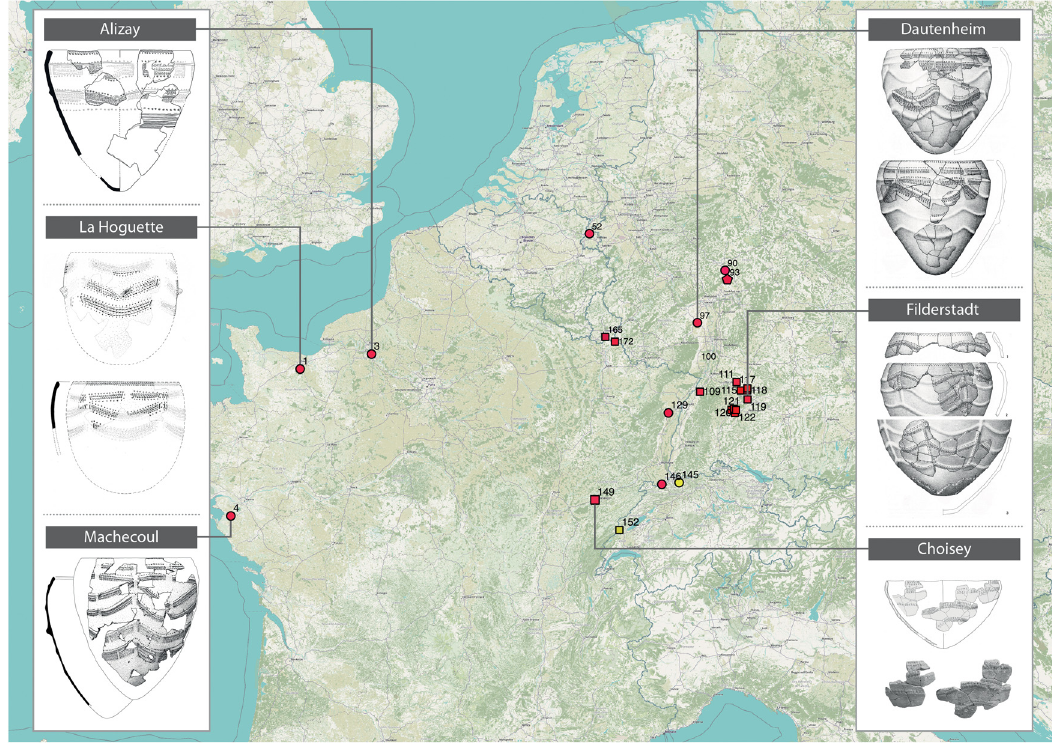
Figure 3: Early bone - tempered Non - LBK vessels ( Drawing: Author with fi gures from Caillaud & Lagnet, 1972, p. 151; Lüning et al., 1989, p. 400, Figure 14, p. 412, Figure 26.3, p. 414, Figure 28.2; Pétrequin et al., 2009, p. 495; Ghesquière & Aubry, 2013, p. 518; Rousseau et al., 2015, p. 24 )